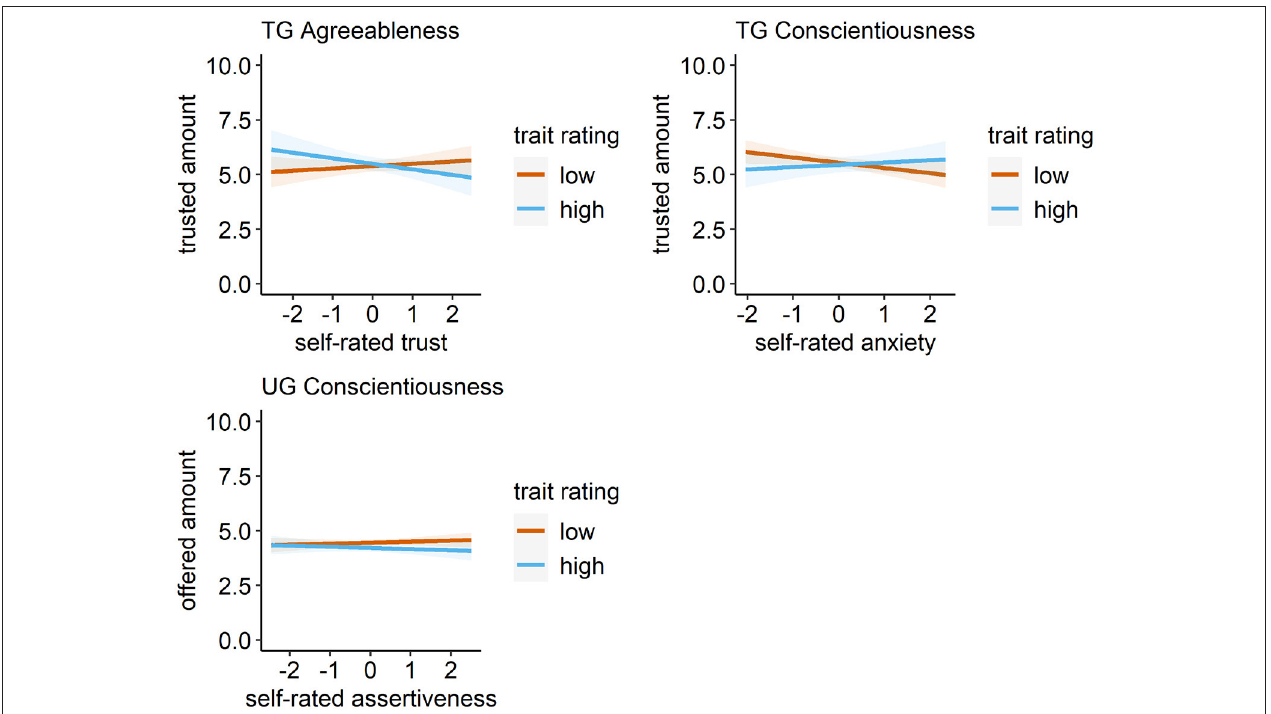
FIGURE 1 | Significant cross-level interactions between self-rated personality and trait-ratings. In the first row, significant interactions between self-rated trust and anxiety for trait-ratings of prototypical agreeableness and conscientiousness faces, respectively, in the trust game (TG) are presented. In the second row, the significant interaction between self-rated assertiveness and the trait rating for prototypical conscientiousness faces in the ultimatum game (UG) is presented. For graphical illustration, we used a median split categorize the trait-ratings of the faces into high and low. Shaded areas represent the 95% confidence